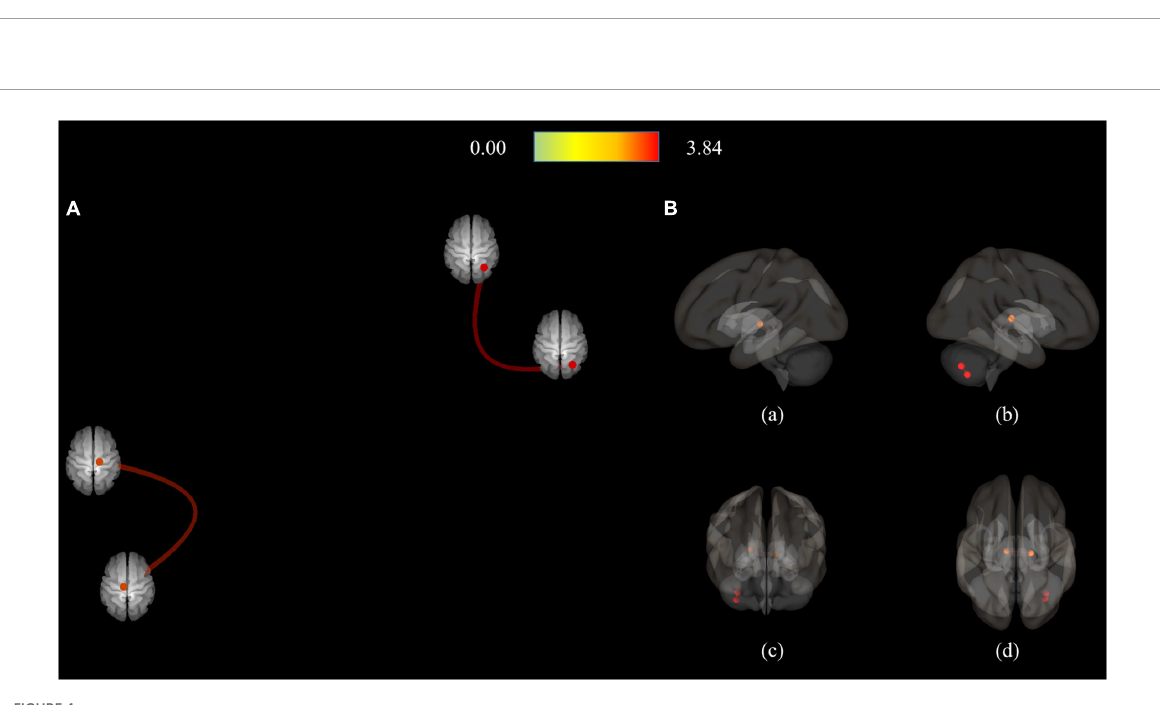
FIGURE4 Connection pairs of HC < MDD functional connectivity within 71 ROIs for the ROI-to-ROI analyses. (A) ROI-to-ROI connectome ring maps. (B) ROI-to-ROI 3D rendering maps on the left (a), right (b), anterior (c), and superior view (d). The color bar indicates the statistical T -value. HC, Healthy controls; MDD, Major depressive disorder; ROI, Region of